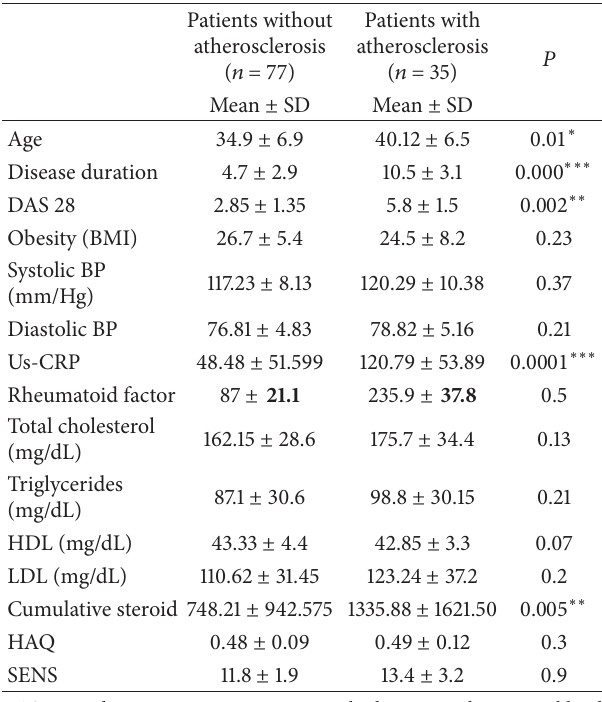
Table 3: Comparison of patients features between patients with and without atherosclerosis.